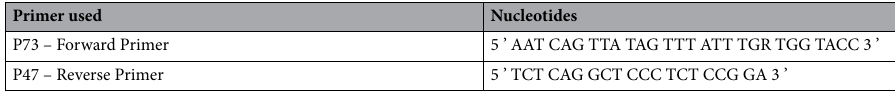
Table 1. 18S rRNA primer used for Molecular characterization of Nitzschia